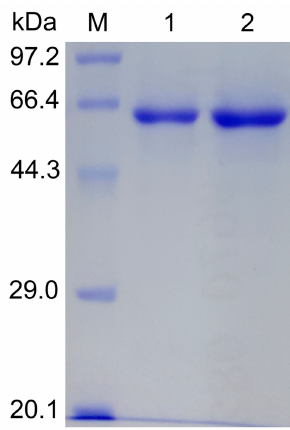
Figure 1. SDS-PAGE analysis of the purified D501G mutant and wild-type laccase. Lane M: protein marker; Lane 1: the D501G mutant; Lane 2: the wild-type